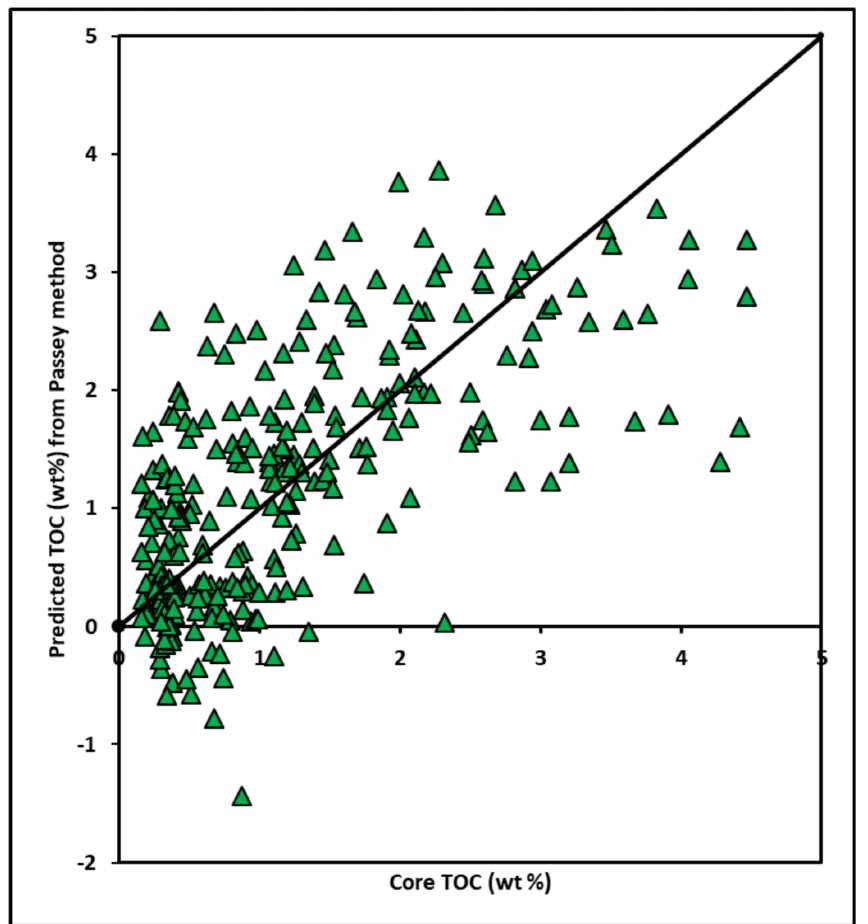
Figure 12. Cross ‐ plot of core TOC from Rock ‐ Eval Pyrolysis and computed TOC from Passey method. The black line represents a 1:1 ratio between input and output variables. MSE and R 2 values are 0.694 and 0.44, respectively.